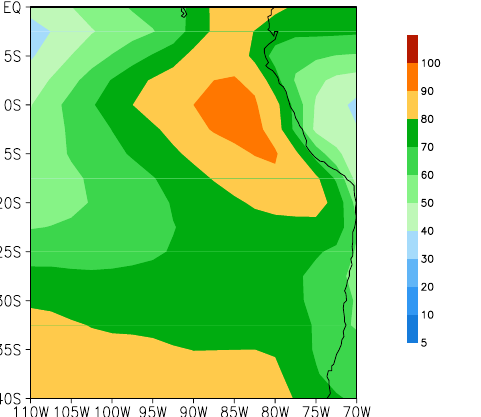
Fig. 4. As in Fig. 2 except for low clouds.